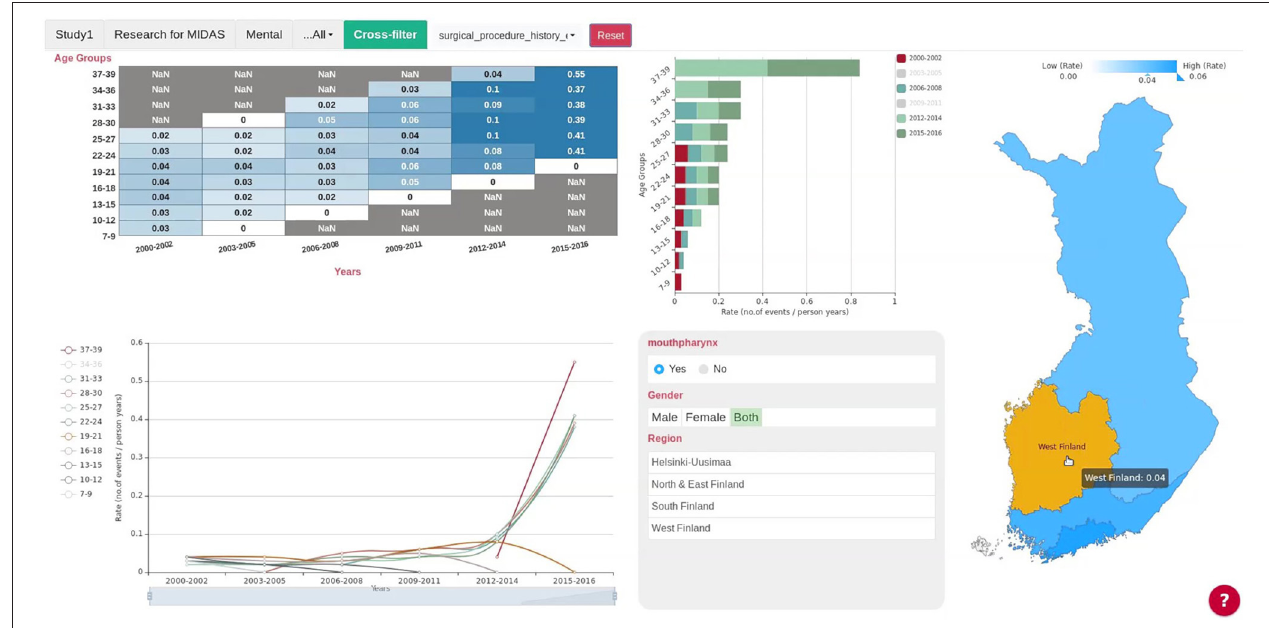
FIGURE 4 | Cross-filter of the Finnish Pilot. Users can select the county or region in the map on the right and all the charts will update automatically. Gender, Region, and Age Group are the categorical variables shown in the lower panel next to the map, and users could select subgroups either by pressing the buttons on the panel or selecting the subgroups in the line chart or bar chart. The Finnish cross-filter consists of a matrix heatmap, a bar chart, a line chart and the regional map of Finland. The cross-filter of other pilots have different components.